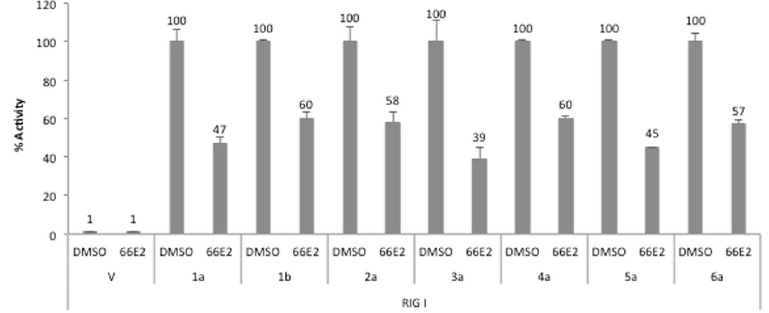
Figure 4. Pangenotypic effect of 66E2. Cell-based assay was performed with RdRps from all six major genotypes of HCV, along with vector (V) as control, in the presence of 10 μ M 66E2. DMSO was used as a control. The assays were performed in triplicates and results presented are representative of three independent assays. The % mean is shown above the bars and the error bars are standard deviations.